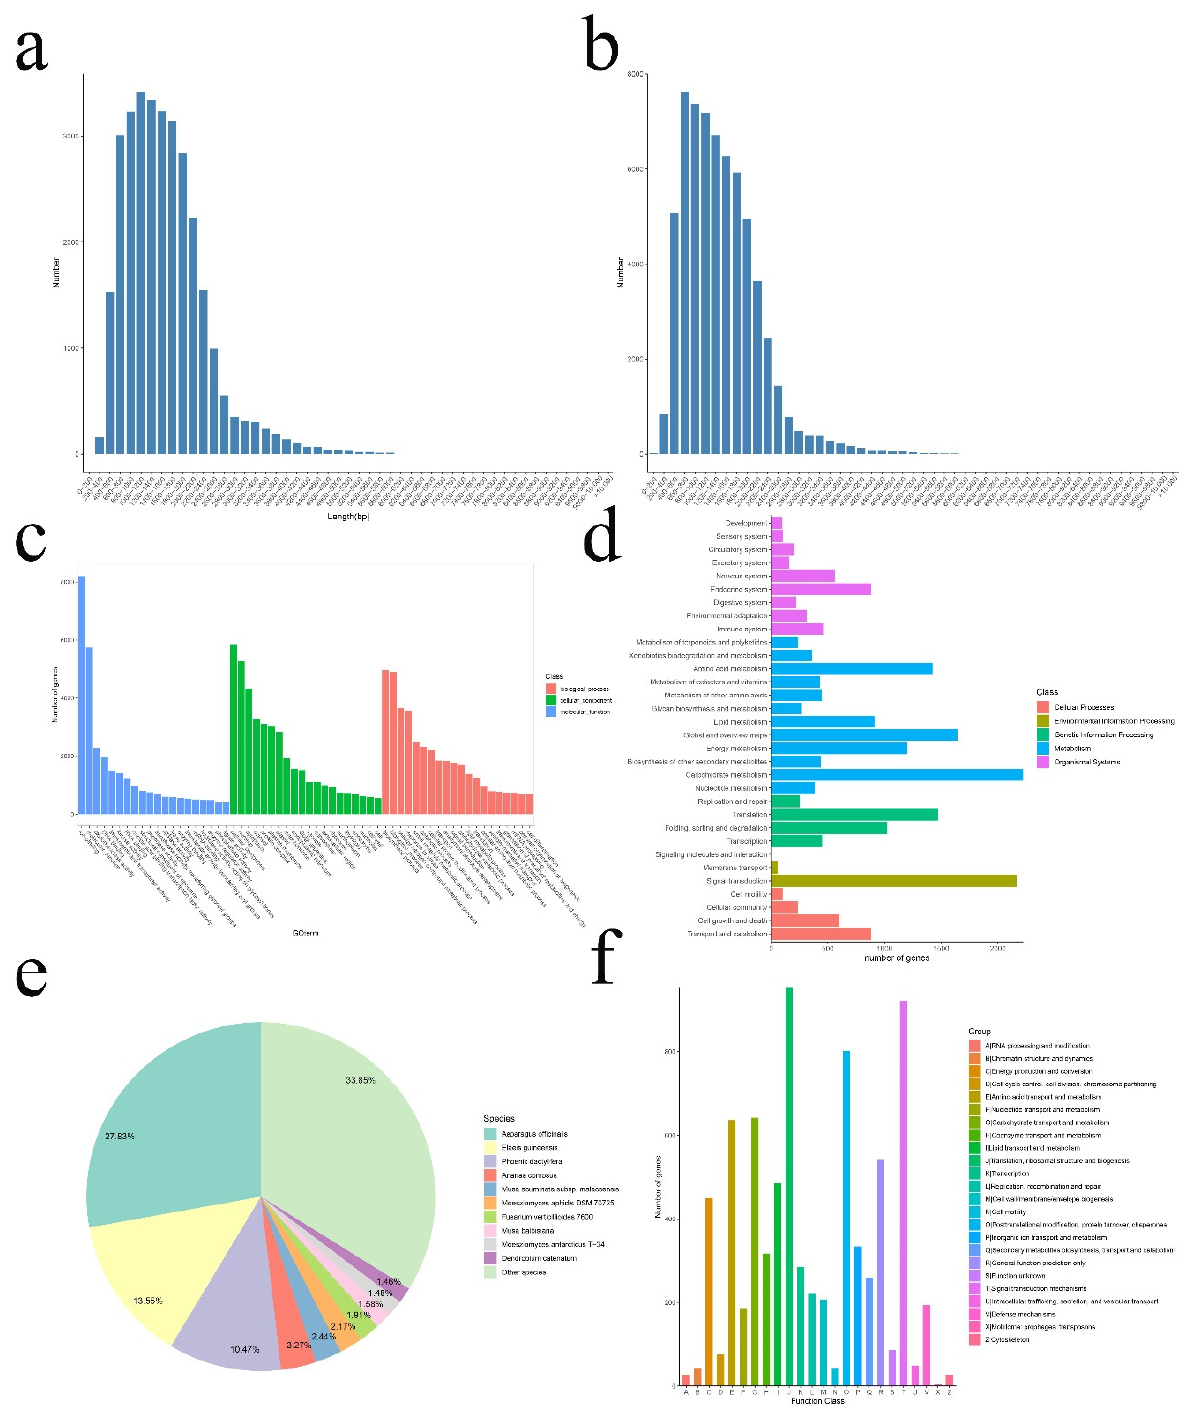
Figure 1. Iso-Seq sequencing, assembly, and annotation of I. lactea var. chinensis . ( a ) Length distribution of the isoform. ( b ) Length distribution of the full-length transcripts. ( c ) Gene Ontology (GO) classification of the assembled full-length transcripts. ( d ) Kyoto Encyclopedia of Genes and Genomes (KEGG) annotation of the assembled full-length transcripts. ( e ) The distribution of homologous species annotated in the NCBI non-redundant protein (NR) database. ( f ) Cluster of Orthologous Groups of proteins (COG) classification of the assembled full-length